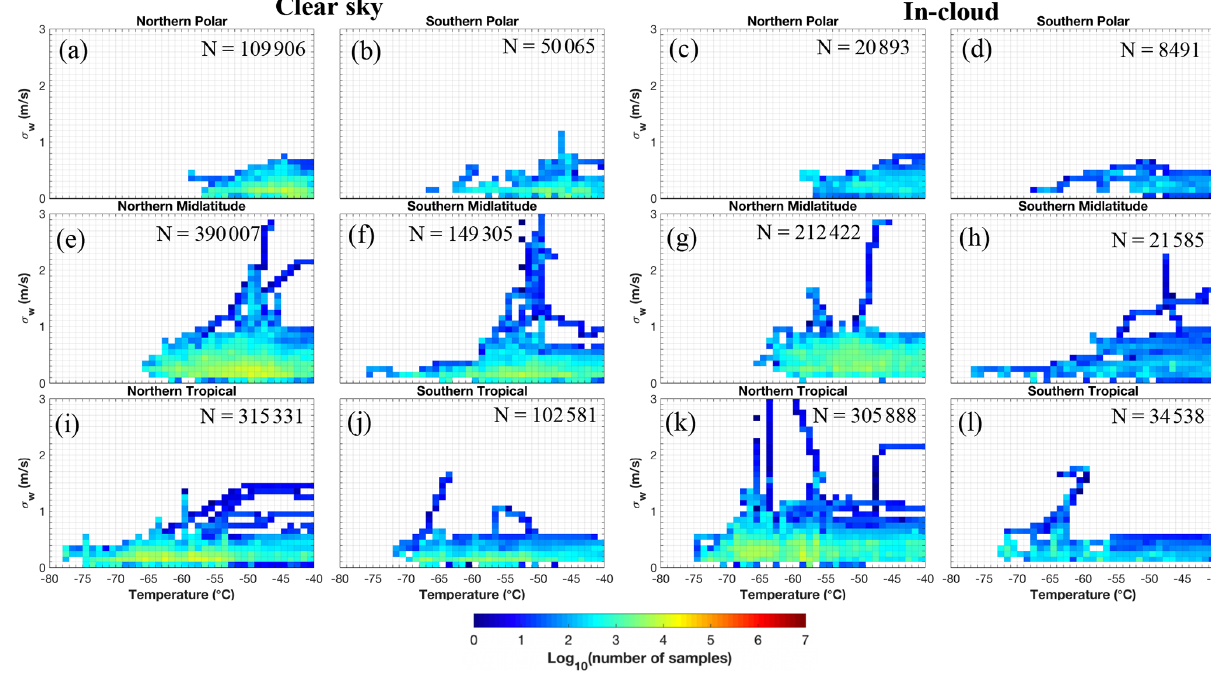
Figure 10. Similar to Fig. 9 but for 430s averaged observations.